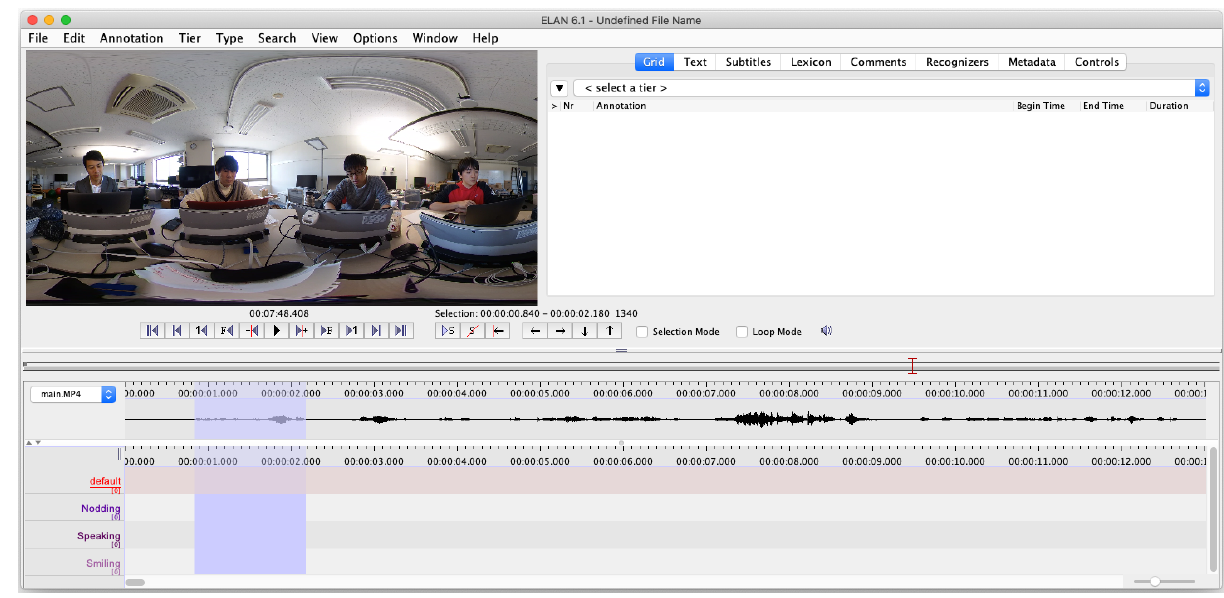
Figure 4. Participants use ELAN [43] to create annotations of their micro-behaviours. Each annotation contains time duration. Annotations are performed right after each meeting session was completed. After annotation, each participant exports data into a csv file.